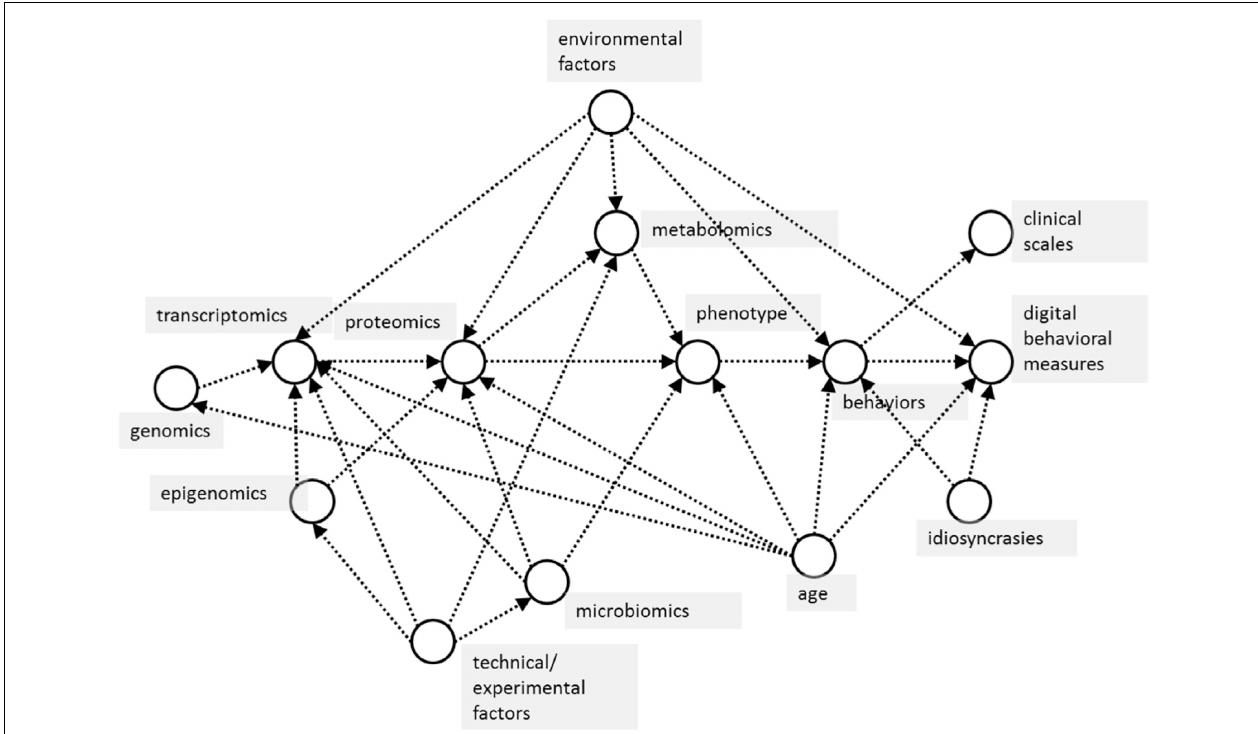
FIGURE 1 | Basic causal model of proposed relationships between measured variables in the CCBP cohort study. Arrows between variables (in circles) indicate the dominant direction of causal influence between them. In this study, machine learning is used to model predictive relationships, but these should also be causal, not merely associational, relationships. For example, in predicting phenotype (effect) from omics data (causes), confounders such as subject age influence both cause and effect variables, which makes it critical to take these into consideration when using predictive machine learning